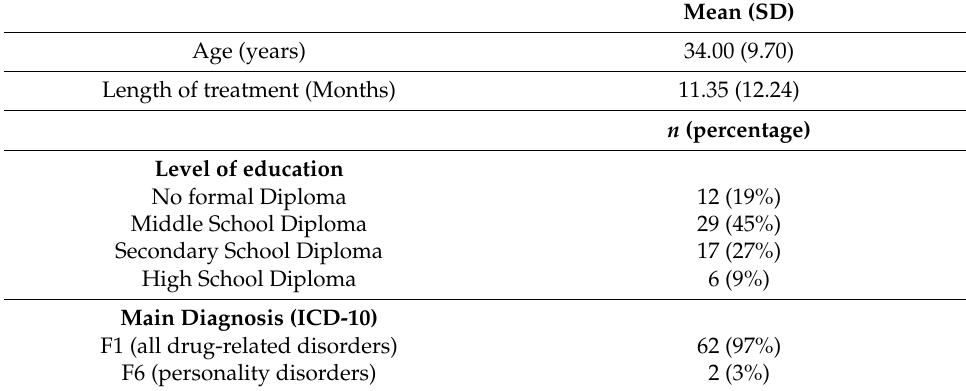
Table 1. Descriptive statistics of the patient population (SD = standard deviation; n =